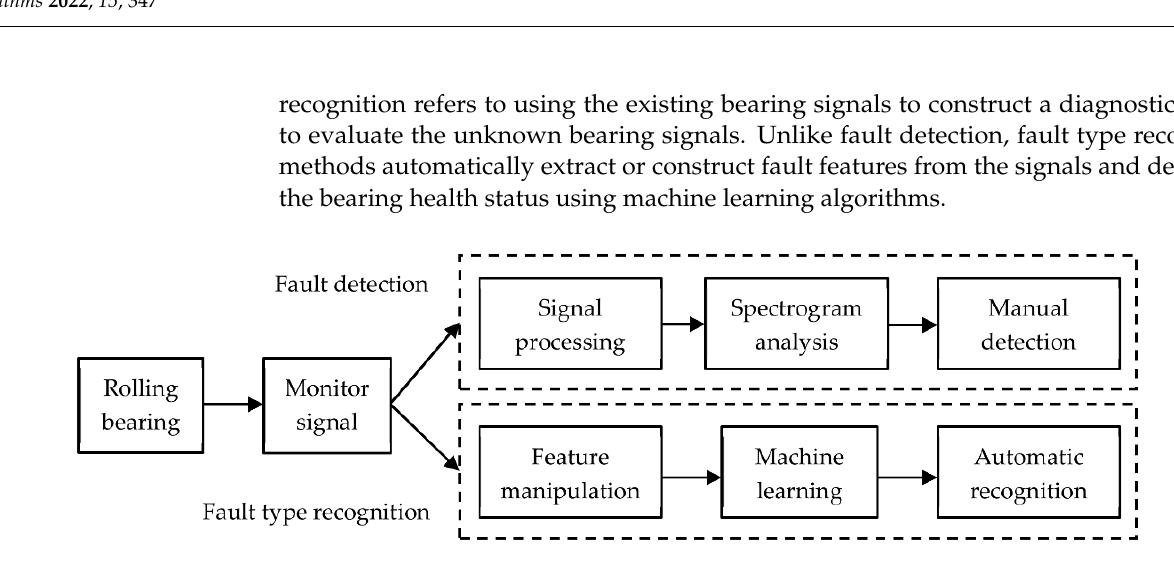
Figure 2. General flowchart of rolling bearing fault diagnosis.